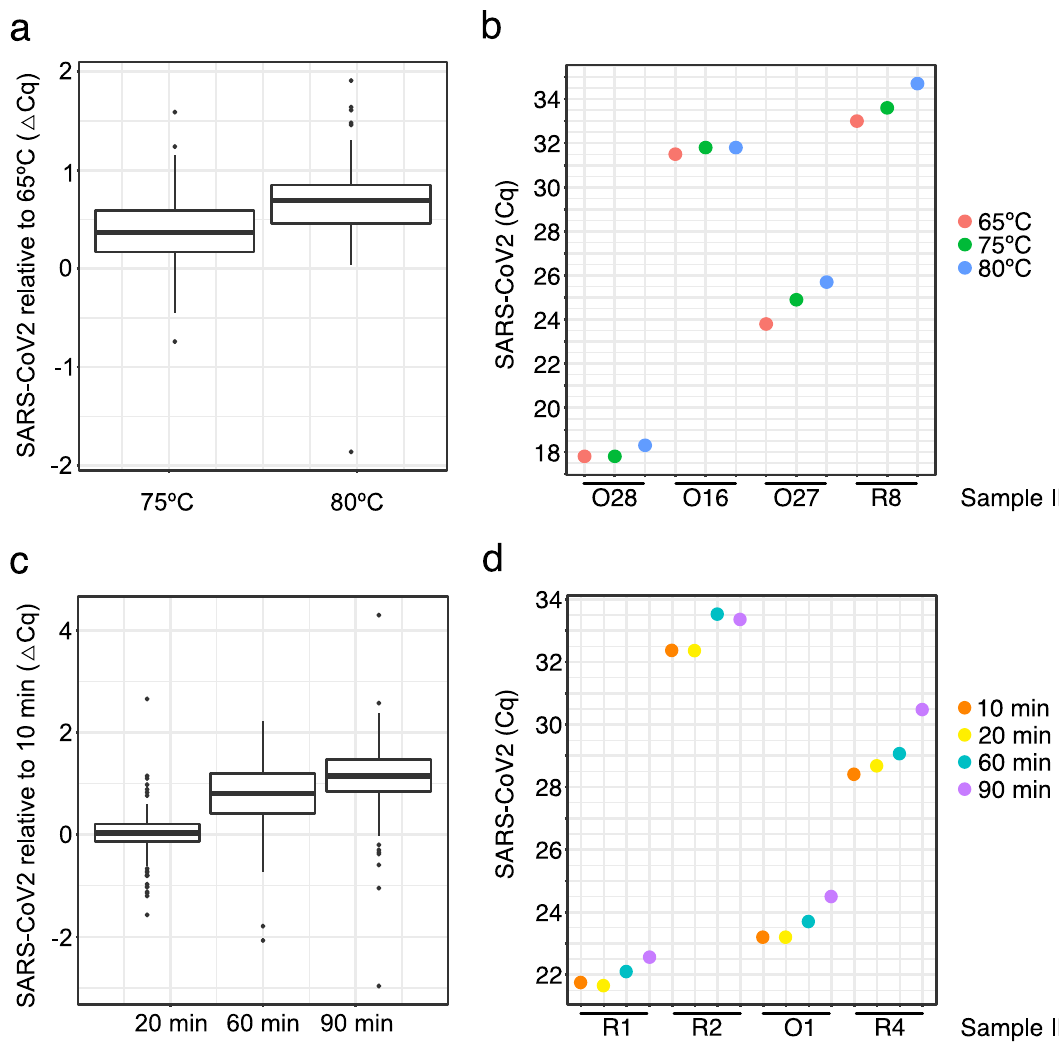
Figure 2. SARS-CoV-2 detection by RT-qPCR following heat treatment. ( a ) Impact on SARS-CoV-2 RT-qPCR Cq value in OP/NP samples following incubation at 70 °C and 80 °C compared to 65 °C for 10 min. ( b ) Selected samples from ( a ) showing the effect is not Cq dependent. ( c ) Impact on SARS-CoV-2 RT-qPCR Cq value in OP/ NP samples following incubation at 65 °C for 20, 60 and 90 min compared to 10 min. ( d ) Selected samples from ( c ) showing the effect is not Cq dependent. See Supplementary Tables 2 and 3 for summary statistics. Data was plotted using R (v4.1.0 “Camp Pontanezen”) with ggplot2 (v3.3.3) and the figure was assembled using Affinity Designer